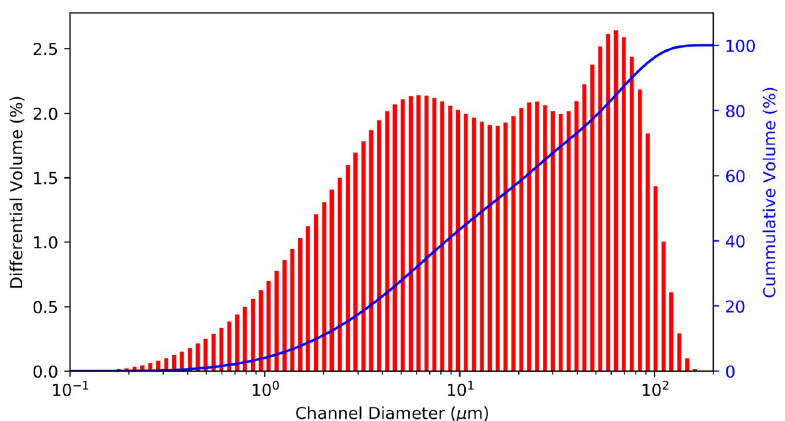
Figure 2. CSP particle size distribution.